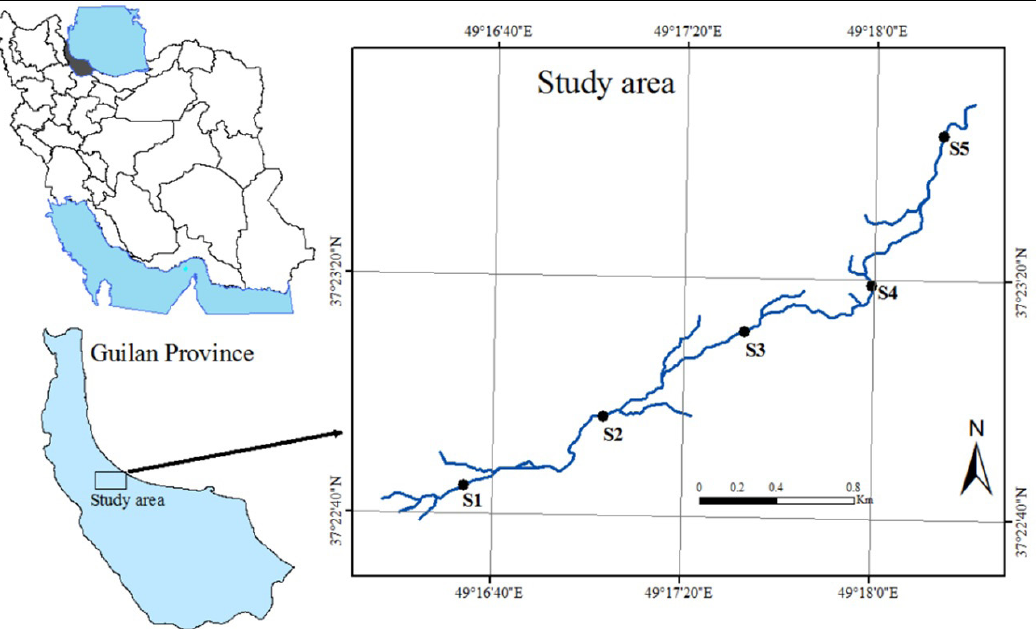
Figure 1. Location of the sampling stations along the Masuleh